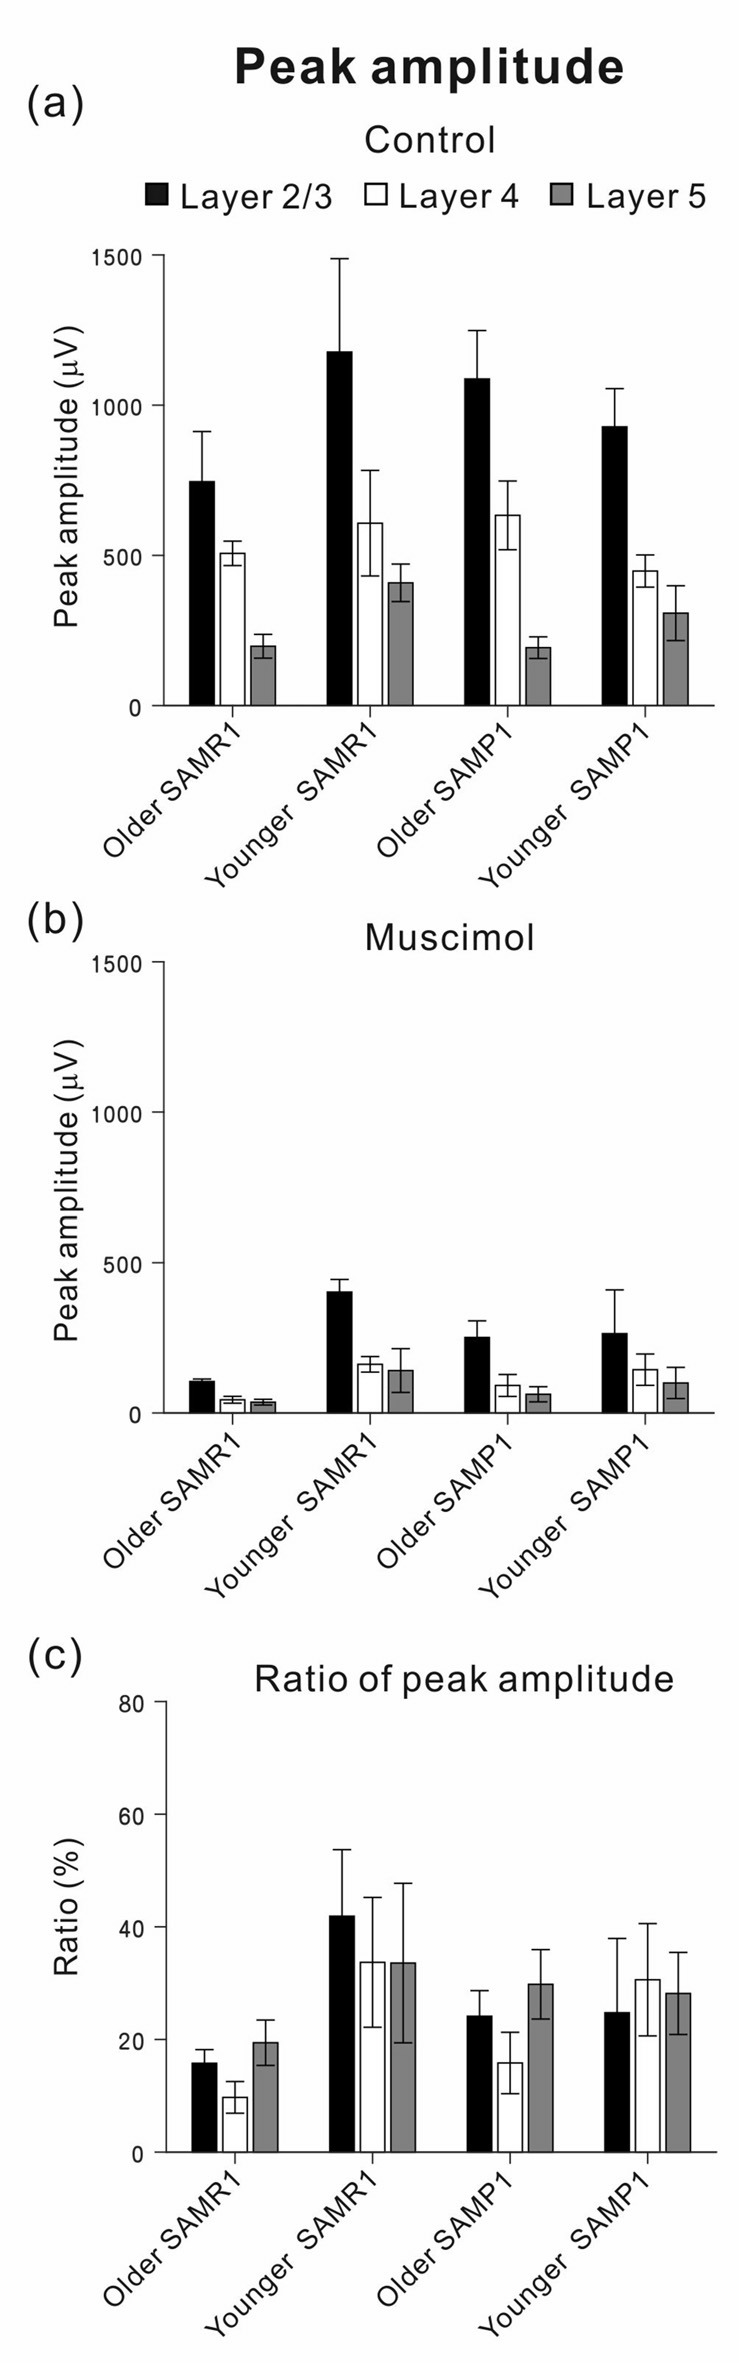
Among the four mouse groups (younger and older SAM-R1 and -P1), peak amplitudes of stimulus-driven LFP responses before and after MSC superfusion are shown. Peak amplitudes (Actl and AMSC) in L2/3 (black), L4 (white) and L5 (gray) among the mouse groups were plotted under the control condition in (a) and the 5-μM MSC superfusion condition in (b), respectively. The ratios of the amplitudes (AMSC/Actl) among the four mouse groups were also illustrated in (c). Error bars represent SEM.